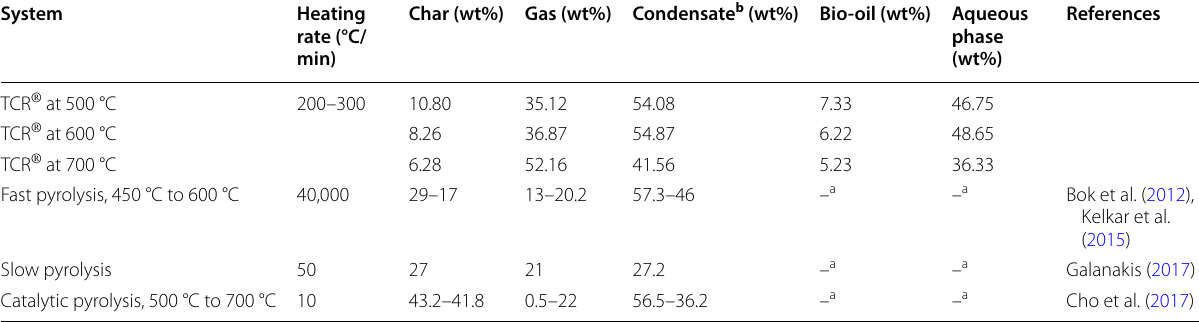
Table 2 Mass balance of products from SCG through TCR ® system and other